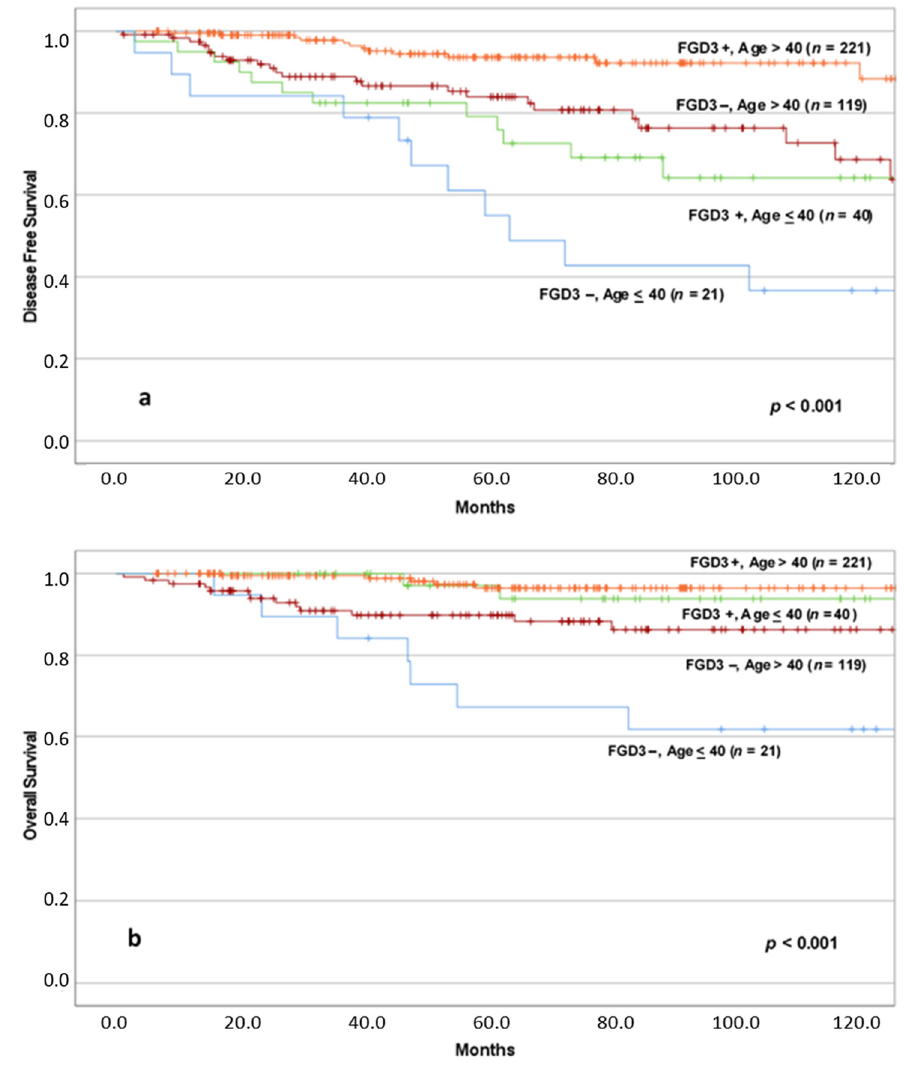
Figure 3. DFS ( a ) and OS ( b ) according to FGD3 expression in age at diagnosis stratified groups.